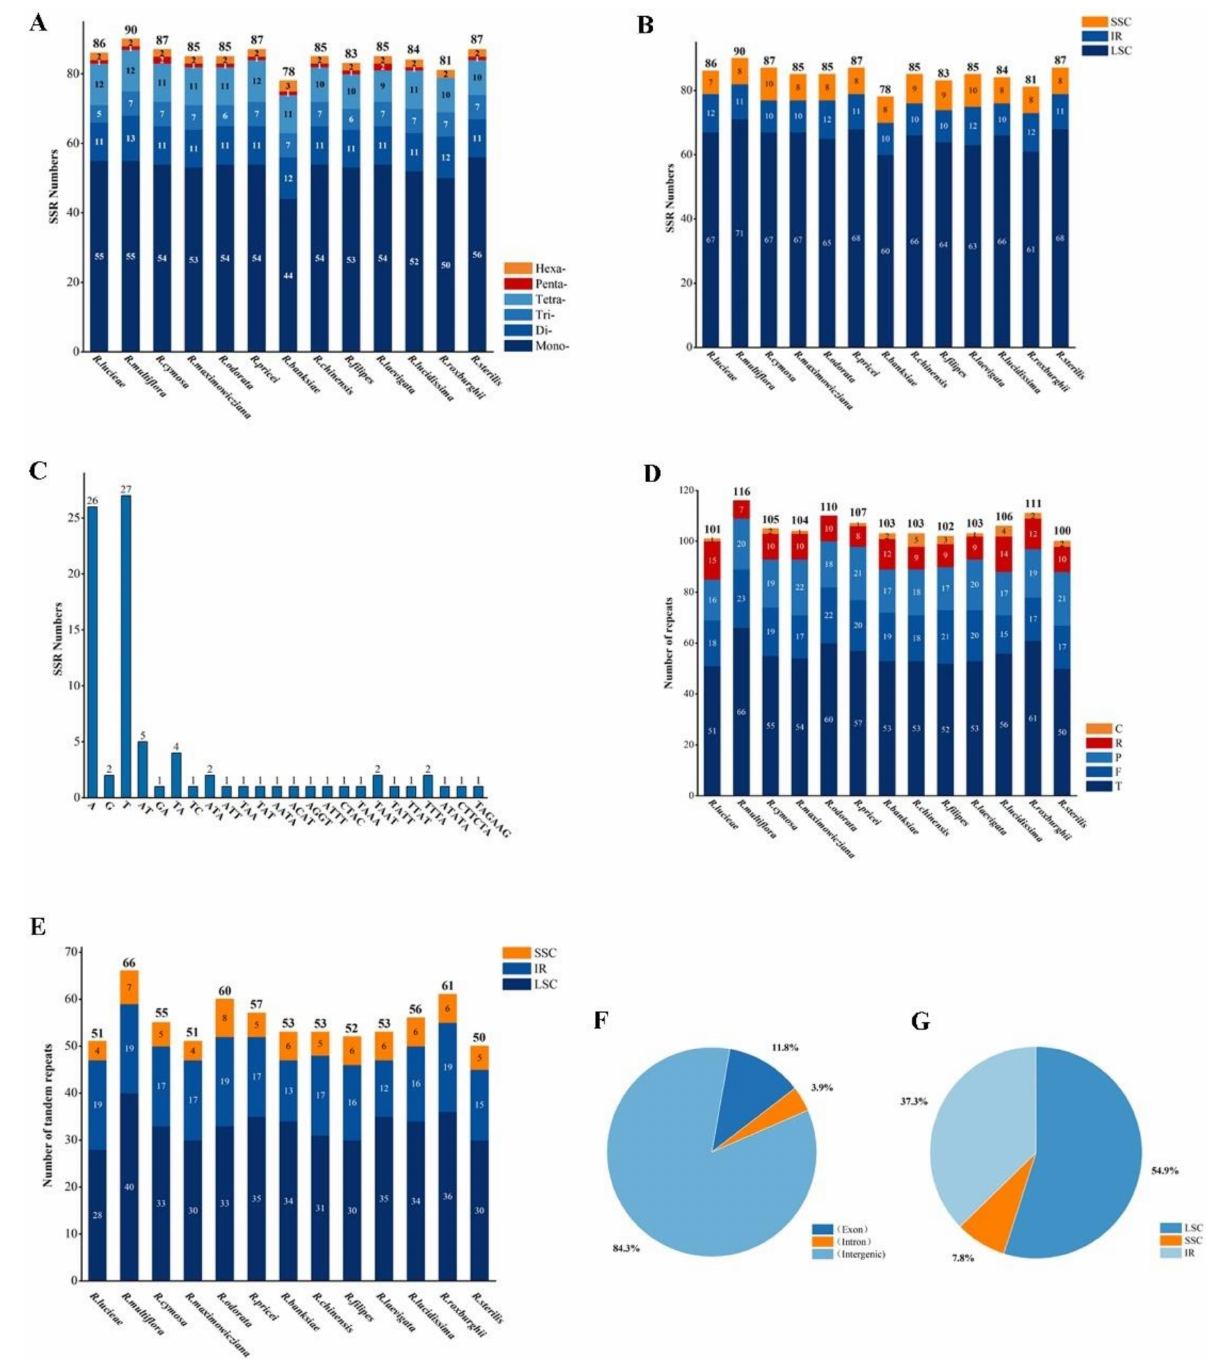
Figure 3. Analysis of sequence repeats in 13 Rosa chloroplast genomes: ( A ) different SSR types detected in 13 genomes; ( B ) distribution frequency of SSRs in the LSC, SSC, and IR regions; ( C ) frequencies of SSR motifs of different repeat types in the chloroplast genome of R. lucieae ; ( D ) thirteen large repeat types were detected in the genome; ( E ) distribution frequency of tan- dem repeats in the LSC, SSC, and IR regions; ( F ) distribution frequency of tandem repeats in exon, intron, and intergenic regions; ( G ) the distribution frequency of tandem repeats in the LSC, SSC, and IR